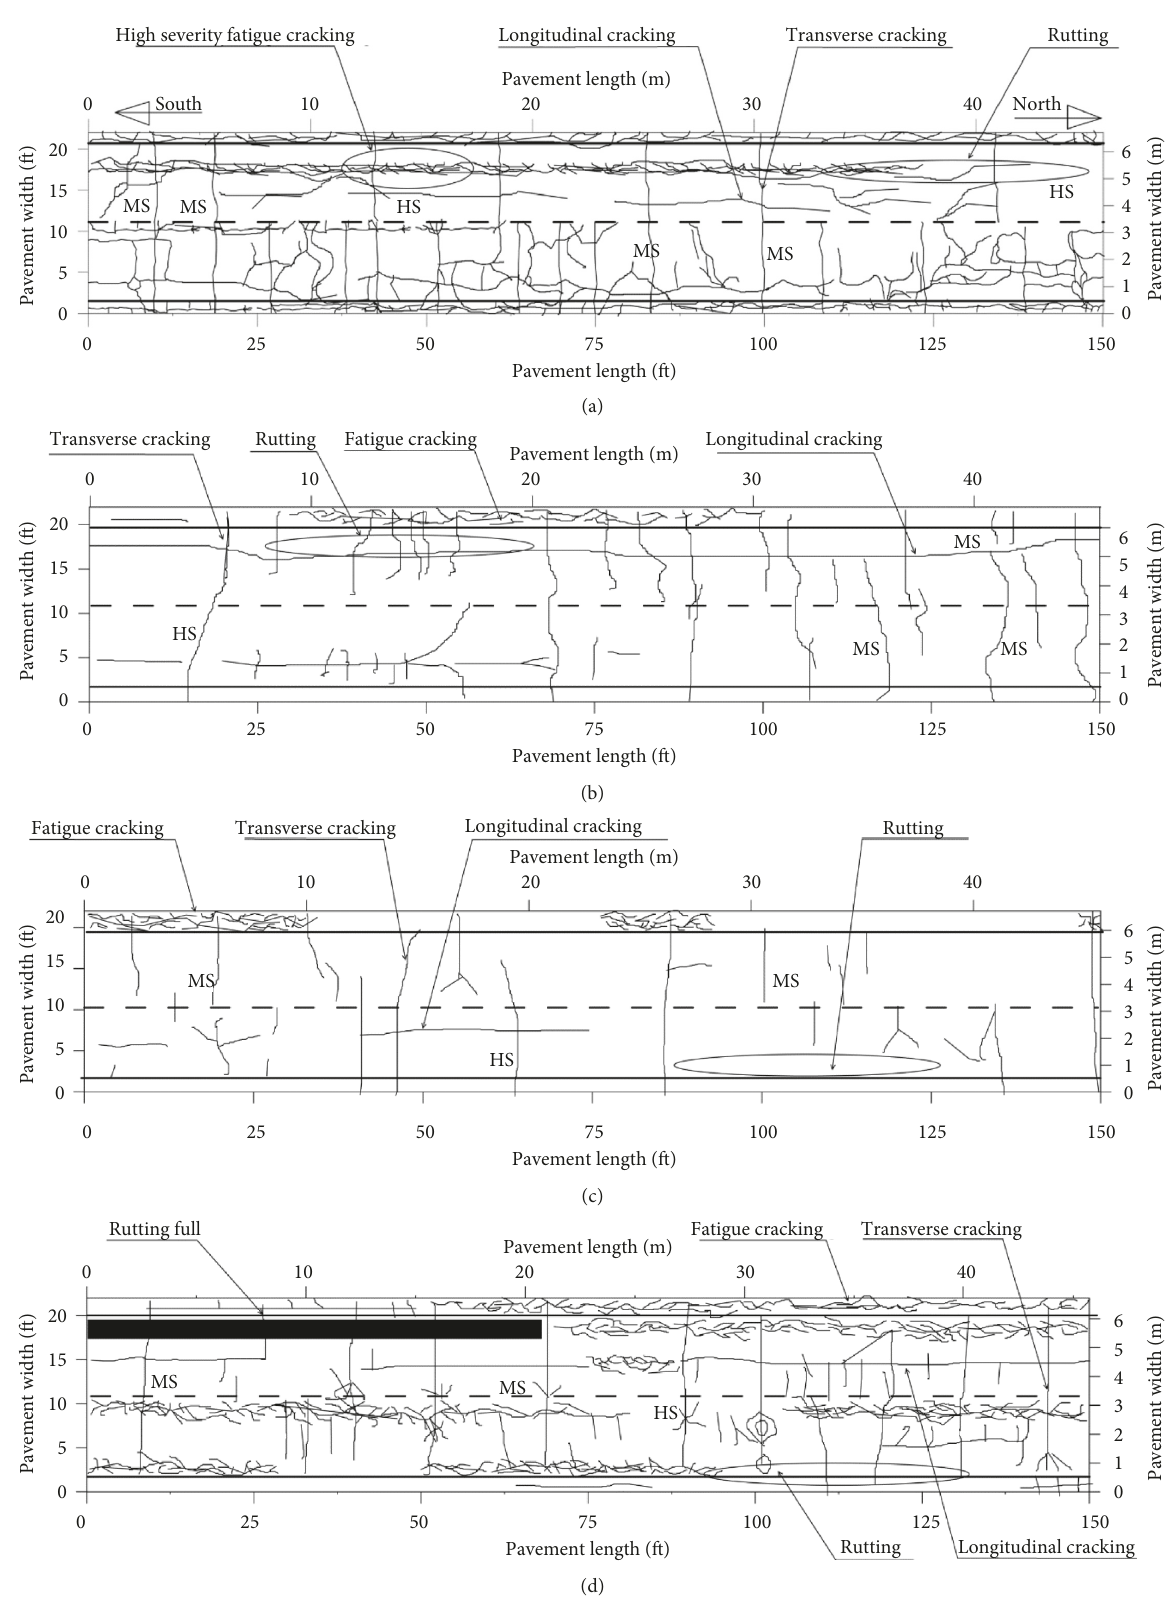
Figure 5: Pavement surface distress observed on investigated pavements. (a) Map of observed distress on STH 140, (b) map of observed distress on STH 11, (c) map of observed distress on STH 23, and (d) map of observed distress on STH 26. HS � high severity; MS � medium